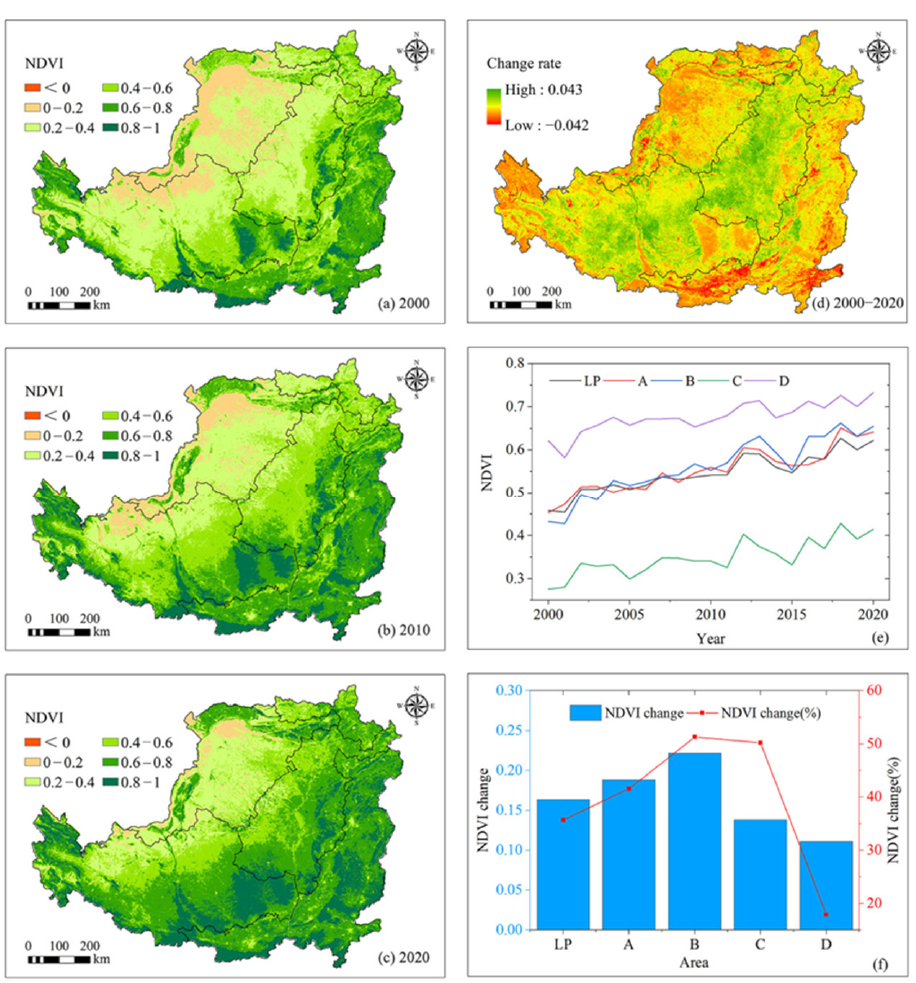
Figure 2. Characteristics of NDVI in the LP from 2000 to 2020: ( a ) spatial distribution of NDVI in 2000; ( b ) spatial distribution of NDVI in 2010; ( c ) spatial distribution of NDVI in 2020; ( d ) spatial variation trend of NDVI; ( e ) interannual variation in NDVI; ( f ) NDVI change value and rate.